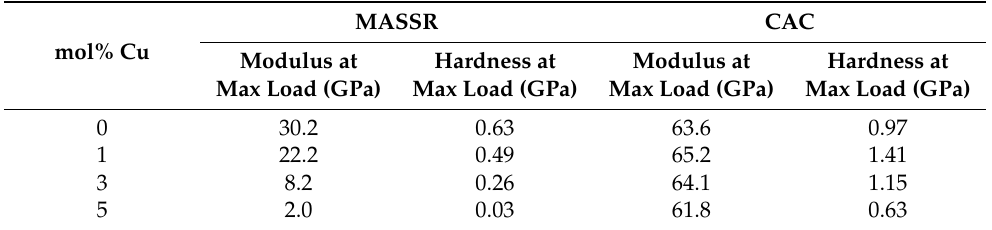
Table 2. Mechanical properties of MASSR and CAC ceramics determined by the